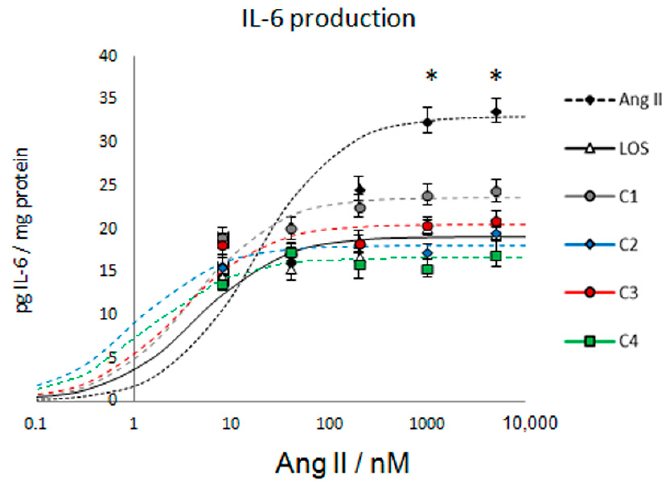
Figure 2. Concentration–response curves of the assessed combinations on Ang II-induced IL-6 production, 12 h after treatment. Losartan (LOS) was used as a positive control. C1 = 0.08 µ g/mL of SF1 and 0.08 µ g/mL of SF3; C2 = 0.08 µ g/mL of SF1 and 10 µ g/mL of SF3; C3 = 10 µ g/mL of SF1 and 0.08 µ g/mL of SF3; C4 = 10 µ g/mL of SF1 and 10 µ g/mL of SF3. Data are reported as mean ± SD and were analyzed by ANOVA and the post-hoc Tukey test. n = 5, * p < 0.05 vs. control (Ang II-free).